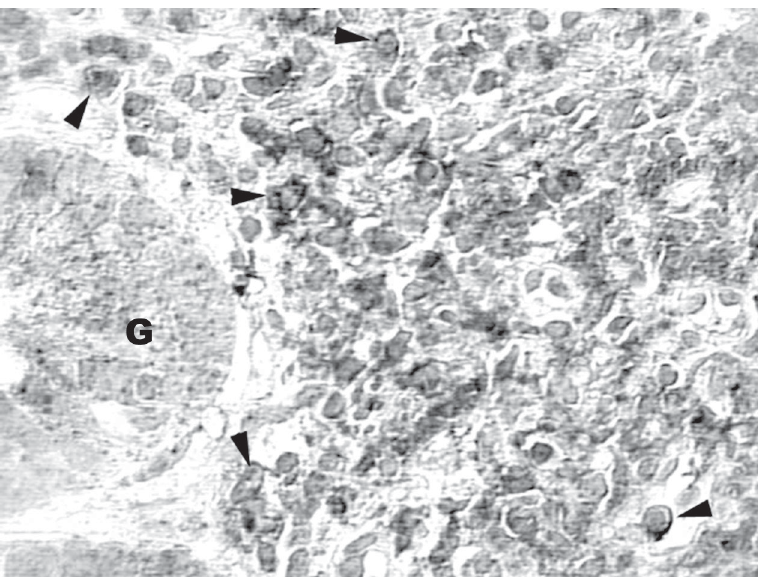
Figure 1. Chronic gastritis: most lymphocytes show membrane reaction with anti-CD95/ APO1 (arrowheads). Glandular cells (G) are negative (800X; bar 12.5 µm).